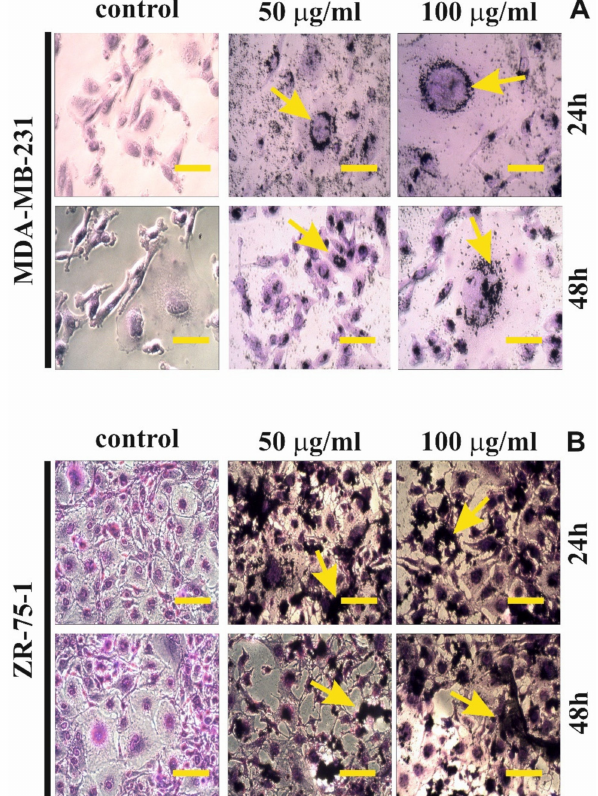
Figure 5. The effect of rGO on morphological changes of MDA-MB-231 ( A ) and ZR-75-1 ( B ) cells evaluated under inverted microscope. The cells were incubated for 24 h and 48 h in 50 µ g/mL or 100 µ g/mL rGO. The cells were observed and photographed under an inverted microscope at 200-fold magnification. We presented representative images from one of the three independent experiments. Scale bar 50 µ